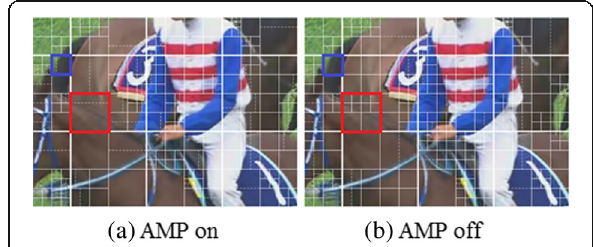
Fig. 3 CU and PU partition of the second frame in “ RaceHorses ” under RA case with QP of 32. a AMP on. b AMP off